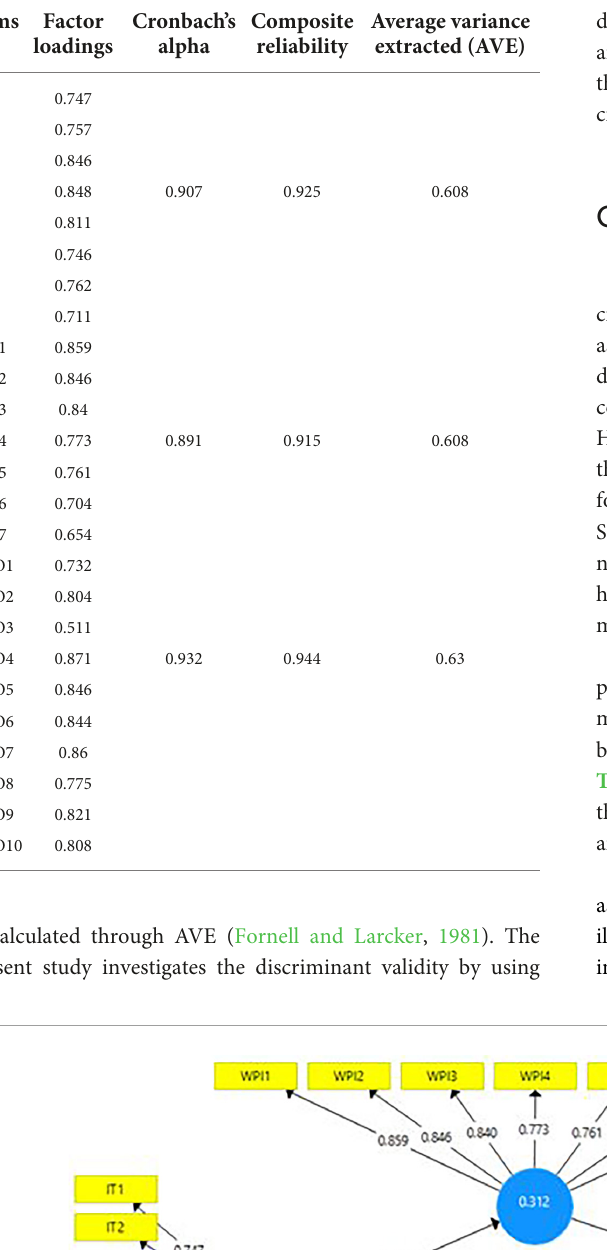
TABLE 1 Outer loadings, composite reliability (CR), and average variance extracted (AVE).